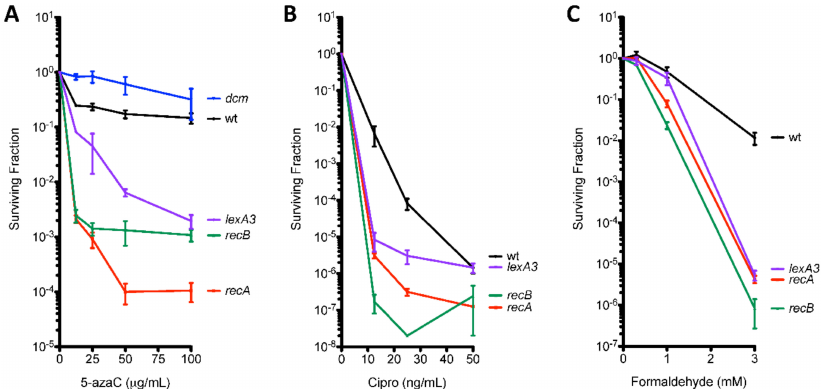
Figure 3. Survival curves. Survival of MG1655 (wt), dcm , recA , recB , and lexA3 strains exposed to 5-azaC ( A ), ciprofloxicin ( B ) or formaldehyde ( C ). MG1655 strains were grown to exponential phase and then treated with drug for 2 h. Each point represents the mean survival of three to five biological replicates with error bars indicating the standard error of the mean. (wt: black, dcm : blue, recA : red, recB : green, lexA3 : purple). Orange dotted lines indicate the doses used in the mutation rate